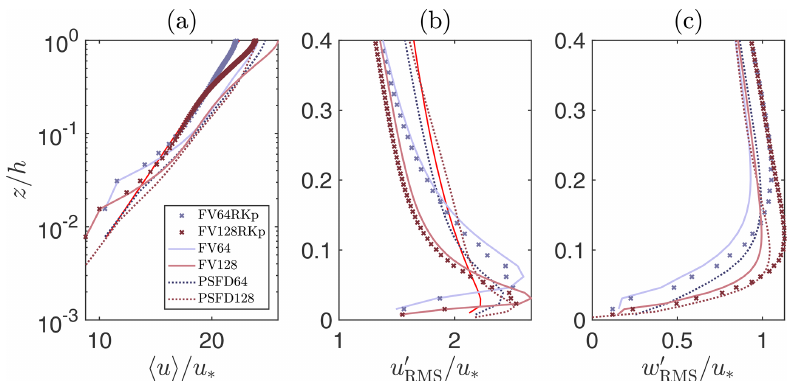
Figure A3. Vertical structure of streamwise velocity (a) , streamwise velocity RMS (b) , and vertical velocity RMS (c) . Red lines denote the phenomenological logarithmic-layer profile (a) and the analytical expressions from similarity theory (Stull, 1988) (b, c) .